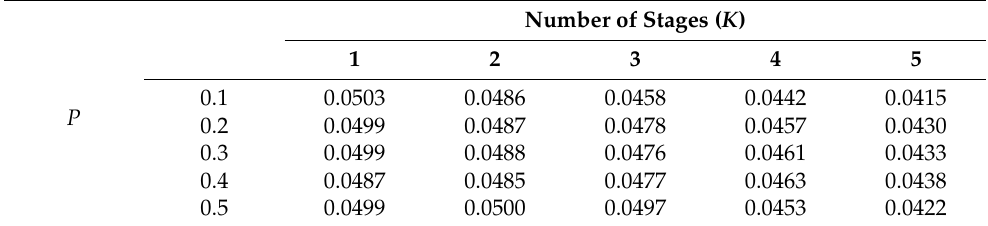
Table 3. Type I values resulted from Monte Carlo simulations for α = 0.05 with the OWMP.